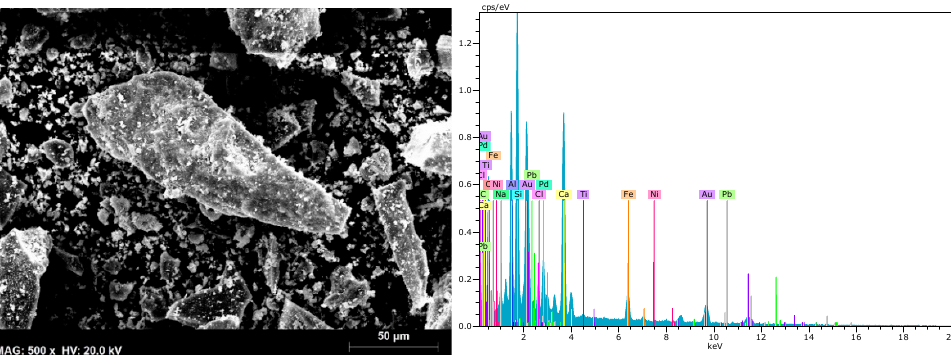
Figure 2. SEM ( left ) and EDS ( right ) of MIBA.